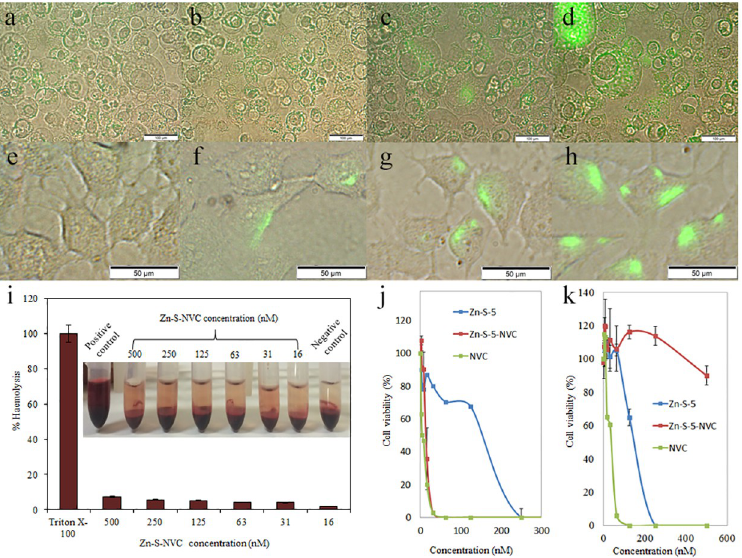
Fig 4. Fluorescence microscopy images. A) PC3 cells exposed to Zn-S-NVC (conjugated to fluorescent dye) at 0 min. B) PC3 cells exposed to Zn-S-NVC (conjugated to fluorescent dye) at 30 min. C) PC3 cells exposed to Zn-S-NVC (conjugated to fluorescent dye) at 60 min. D) PC3 cells exposed to Zn-S-NVC (conjugated to fluorescent dye) at 90 min. E) PNT1A cells exposed to Zn-S-NVC (conjugated to fluorescent dye) at 0 min. F) PNT1A cells exposed to Zn- S-NVC (conjugated to fluorescent dye) at 30 min. G) PNT1A cells exposed to Zn-S-NVC (conjugated to fluorescent dye) at 60 min. H) PNT1A cells exposed to Zn-S-NVC (conjugated to fluorescent dye) at 90 min. I) Haemocompatibility of Zn-S-NVC using human RBCs, showing negligible haemolytic activity in the selected concentration range of Zn-S-NVC (16–500 nM). Inserts show images after incubation and centrifugation. J) MTT analysis of the PC3 cell line. K) MTT analysis of the PNT1A cell